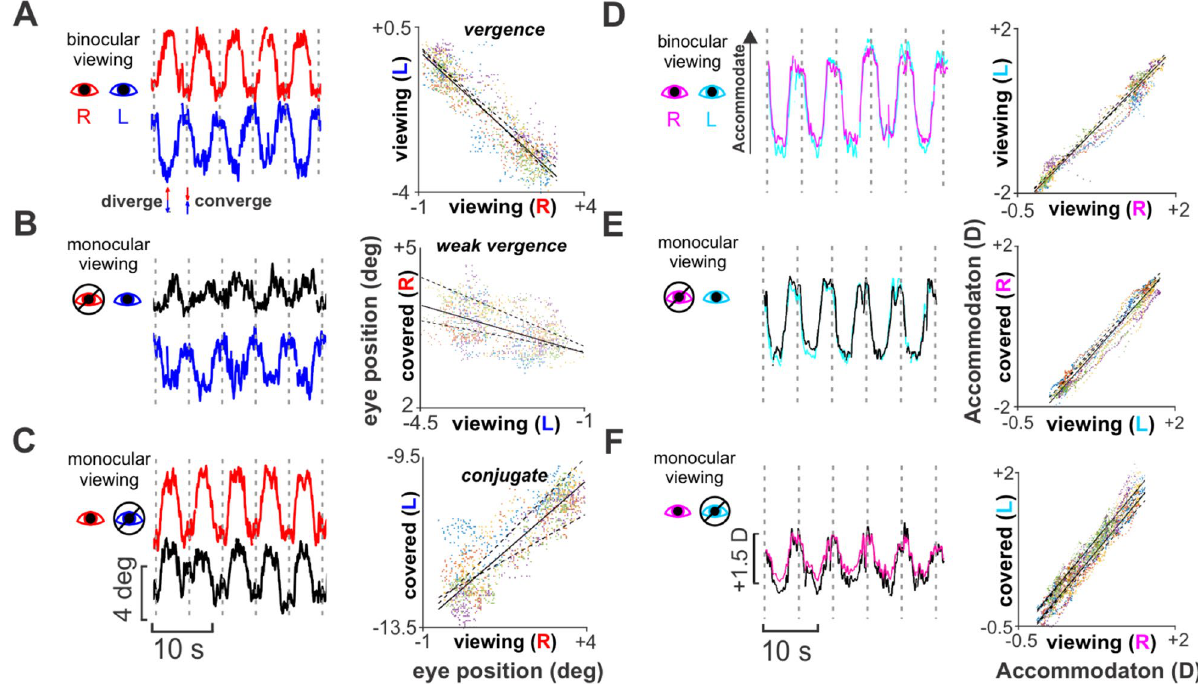
Figure 2. Vergence and accommodation with binocular and monocular viewing. (A) Eye position traces and gaze correlation plots showing interocular gaze slope (IGS) for S13 during binocular and (B ) monocular viewing. (C) Eye position traces and gaze correlation plots measured during monocular viewing for another subject (S11). (D–F) Corresponding accommodation traces and accommodation correlations (interocular accommodation slope, lAS) for (A–C) . Dot colors on correlation plots correspond to different cycles of target movement, and dotted lines of fit correspond to 95% confidence intervals of regression. All gaze and accommodation traces are separated into cycles using vertical dotted